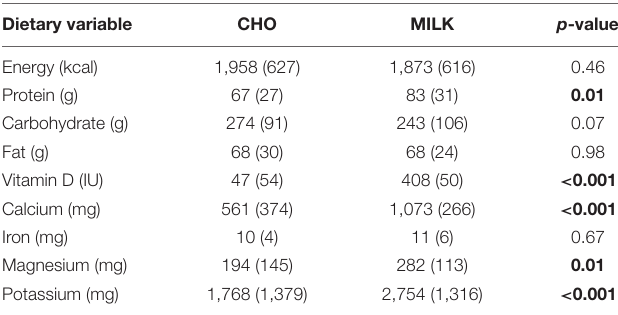
TABLE 1 | Average daily dietary intake during the MILK and CHO trials, based on analysis of 2-day food records (day of exercise and day post-exercise) including the provided trial drinks ( n = 11).